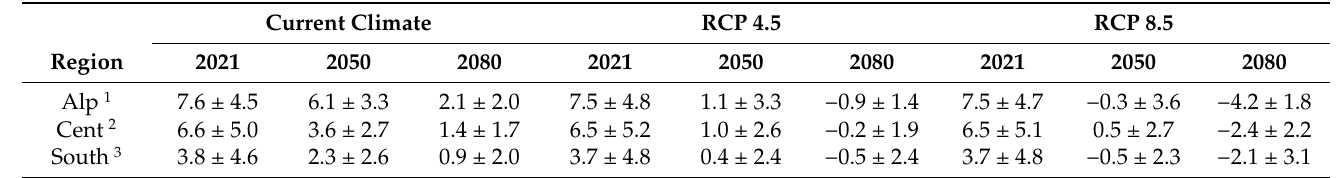
Table 1. GHG budget (mean±standard deviation Mg CO 2 eq. ha −1 year −1 ) of subalpine, central, and southern regions in 2021, 2050, and 2080 under the current climate, RCP 4.5, and RCP 8.5. RCP 4.5